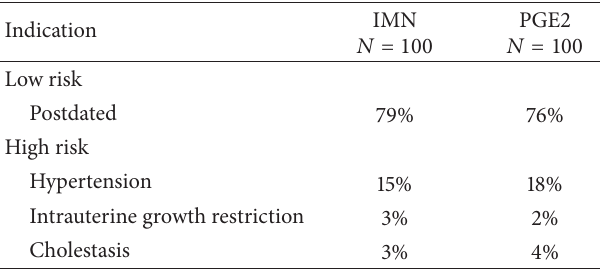
Table 2: Indications for